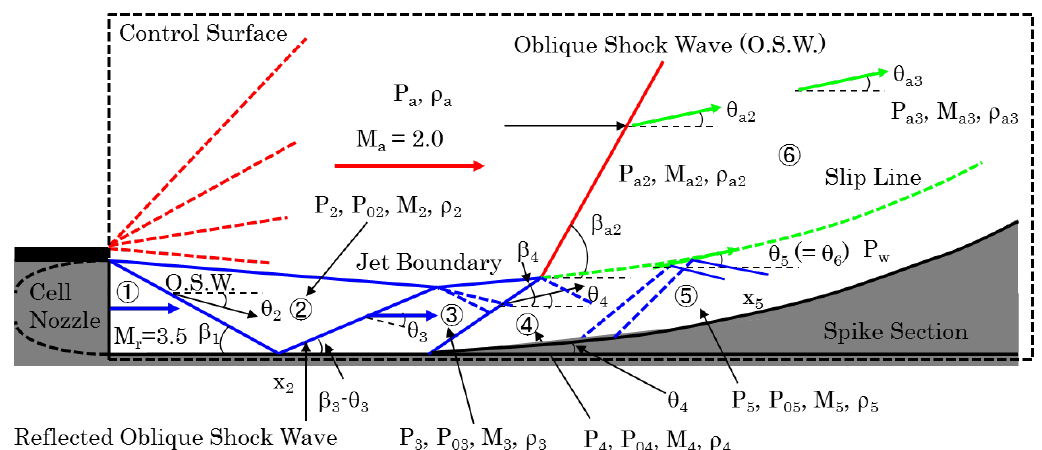
Figure 7. Schematic of the flowfield model with external flow, under the over-expansion condition of jet. This figure is a modified flowfield model of that available in Reference [12].